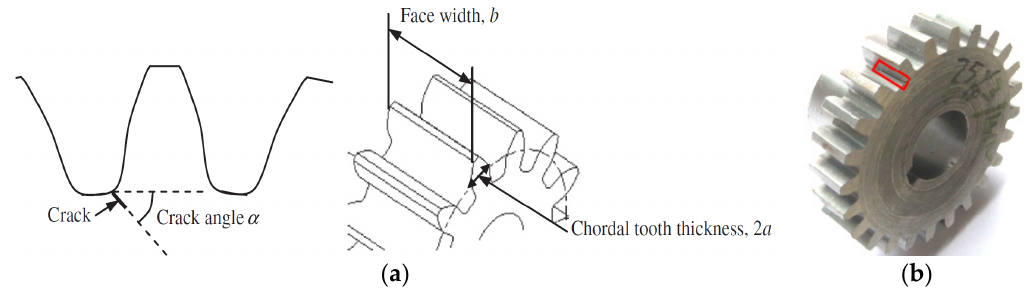
Figure 9. Gear crack angle, face width and chordal tooth thickness and experiment fault gear. ( a ) Crack angle, face width and chordal tooth thickness of a gear; ( b ) 75% level crack in the gear.